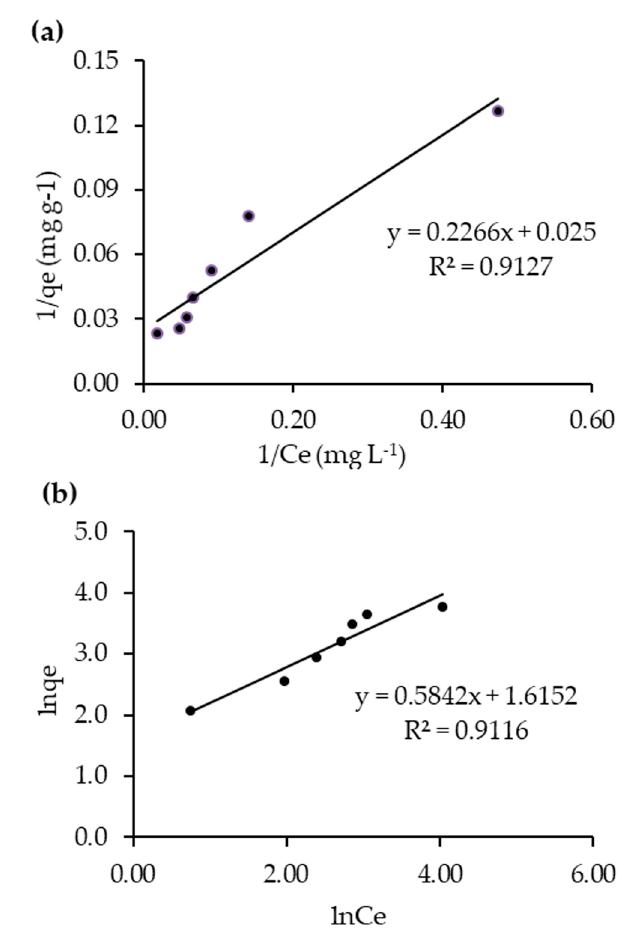
Figure 8. RB5 decolorization data fitness to ( a ) Langmuir and ( b ) Freundlich adsorption isotherms. Table 5. Adsorption parameters and constants of isotherm modeling for 20N–TiO 2 -300 photocatalysts. Isotherms Plot Parameters R 2